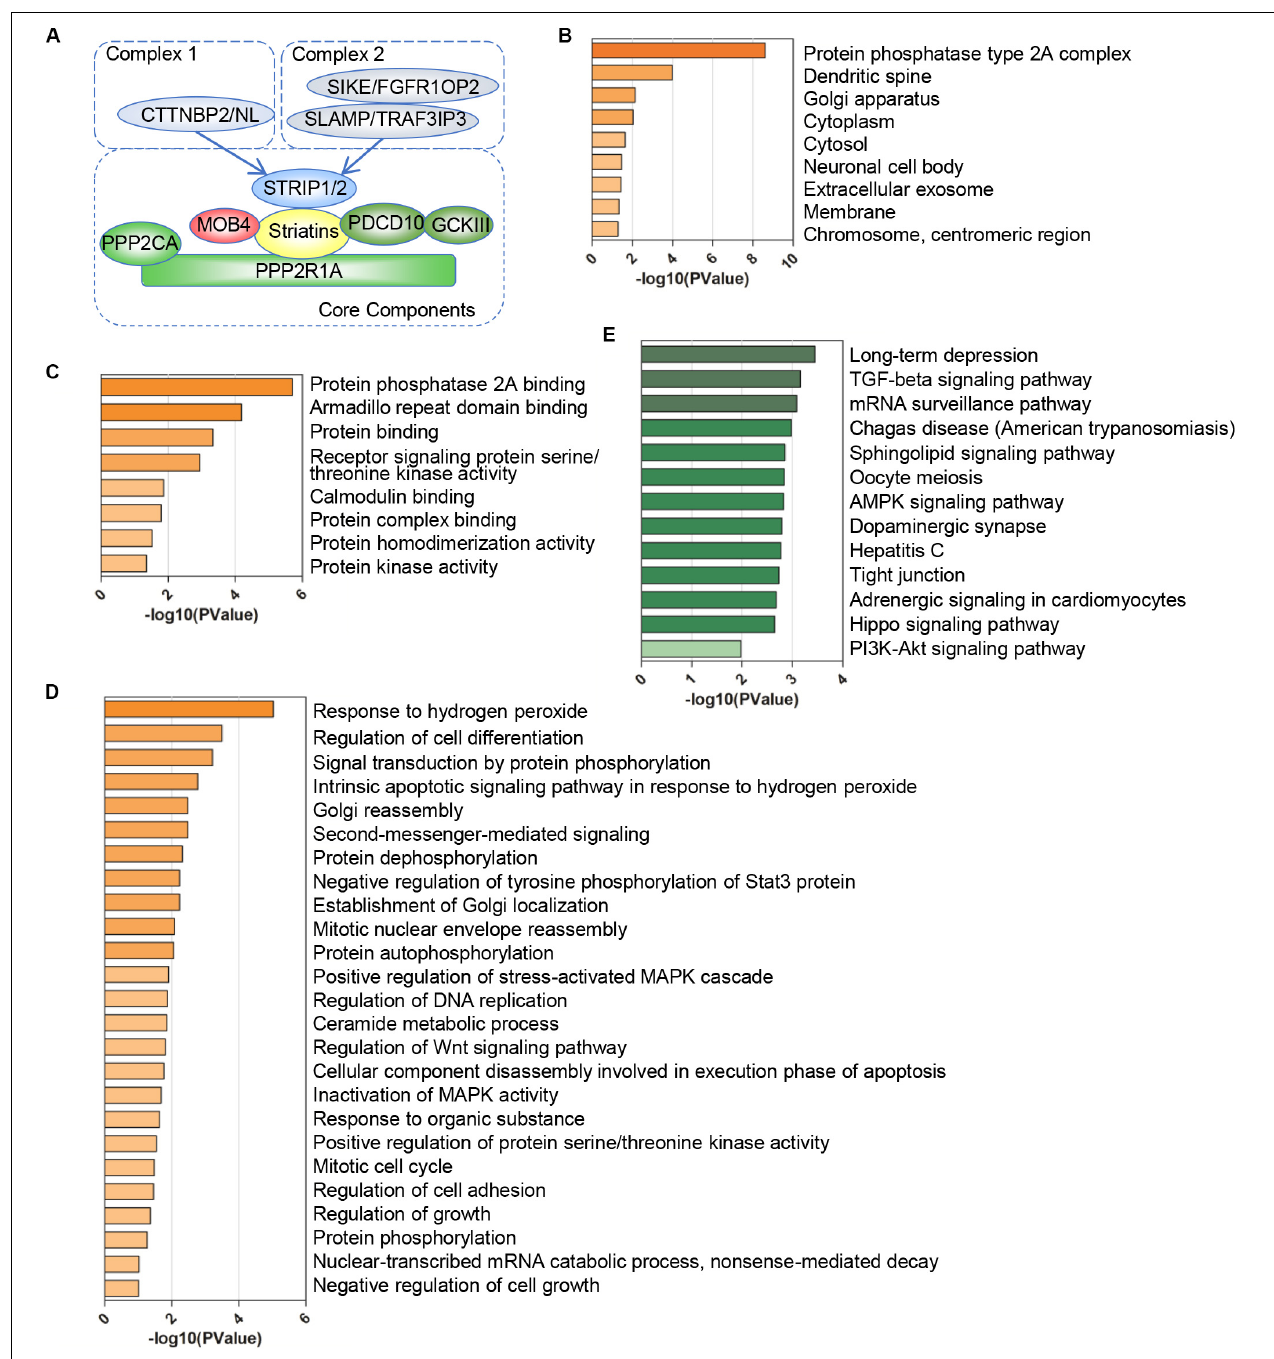
FIGURE 1 | Gene Ontology (GO) and pathway enrichment analysis of the STRIPAK complex. (A) Model of the striatin-interacting phosphatase and kinase (STRIPAK) complex. The core components of STRIPAK complex include STRIP1/2, striatins (STRN, STRN3, STRN4), PPP2R1A, PPP2CA, MOB4, PDCD10, and GCKIII (STK24, STK25, STK26). The core complex may interact with CTNNBP2 family proteins to form complex one, or interact with SLMAP and SIKE family to form complex two. (B–E) The functional enrichment of 18 STRIPAK genes in cellular components (B) , biological process (C) , molecular functions (D) and KEGG pathway (E) , using DAVID online